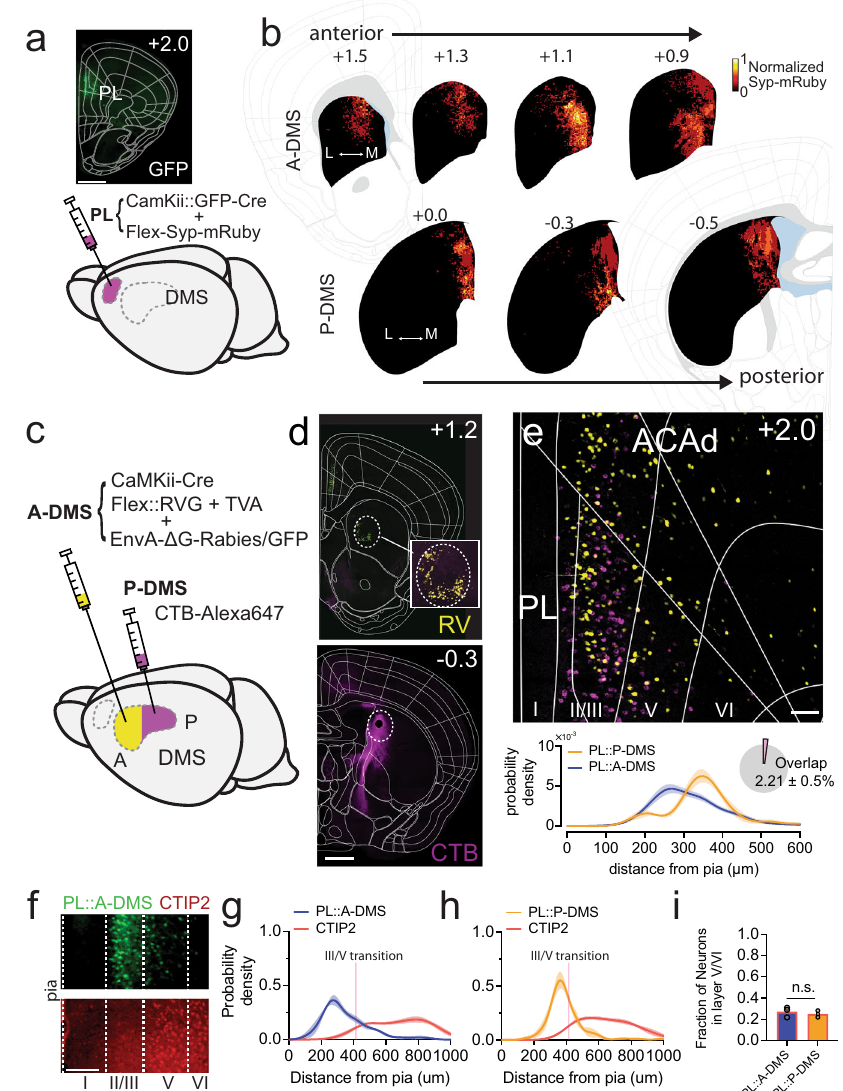
Fig. 1 | Distinct PL neuron populations de fi ned by anterior/posterior dor- somedial striatal (DMS) target. a Approach for anterograde tracing of PL-DMS excitatory projections with synaptic terminal marker Synaptophysin-mRuby (inset shows GFP-Cre expression at PL target site, scale bar, 1000 μ m, n = 4 animals). b Averaged fl uorescent intensity of Synaptophysin-mRuby inputs from PL along anterior-posterior axis, superimposed onto striatum in brain atlas (top: A-DMS, bottom: P-DMS, left to right increasingly posterior, n =4 animals). Top number denotes A/P coordinates from bregma (mm). c Schematic demonstrating dual retrograde tracing strategy using trans-synaptic rabies virus (A-DMS; yellow) and Alexa647-conjugatedCTB(P-DMS;magenta). d Coronalsectionsshowinginjection sites (top: A-DMS, Bottom: P-DMS, n = 5 animals). scale bar, 1000 μ m. Number in upperrightcornerdenotesA/Pcoordinatefrombregma. e Representativeimageof